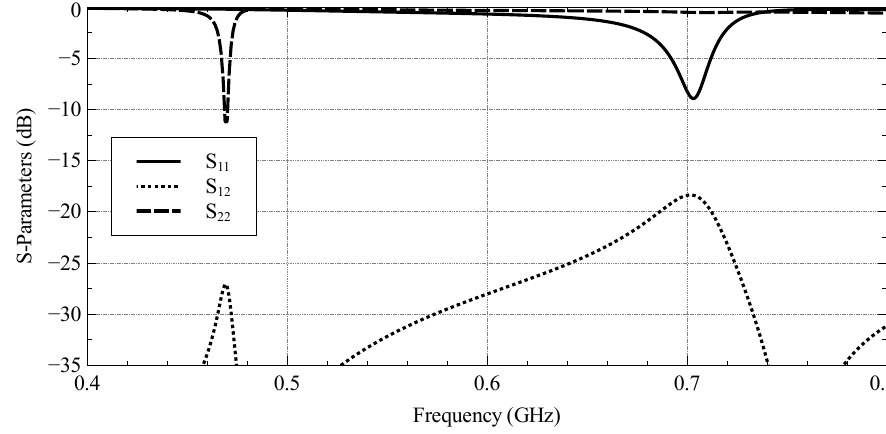
Figure 7. Simulated S-Parameters of antennas with Configuration 2.